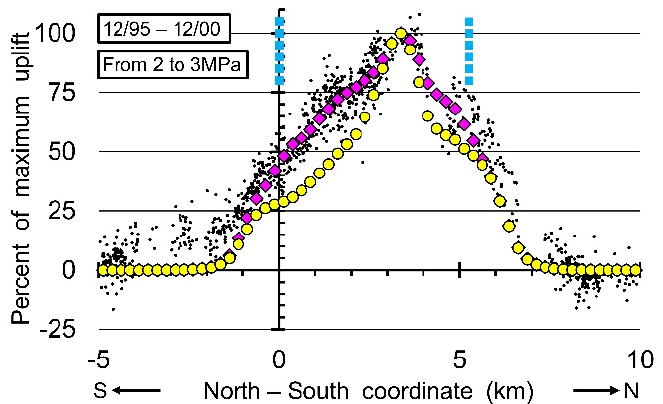
Figure 5. Comparison between InSAR data for the 5-year period from December 1995 through December 2000 (black dots), estimations based on framework and property values developed in [17] (purple diamonds) and estimations for open reservoir scenario and for moduli, as applied by numerical models in [23,24] (yellow circles), whereby the water column changes from 200 to 300 m. The limits of the mined area are indicated by blue square dotted lines.